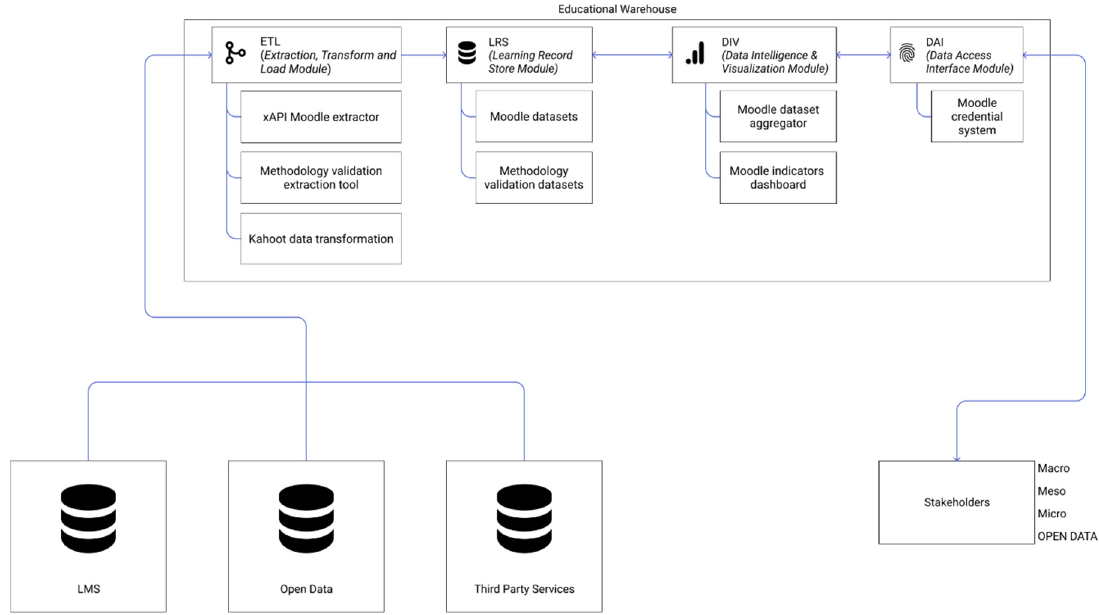
Figure 3. The educational warehouse architecture applied at La Salle–URL: representation of the current modules developed.